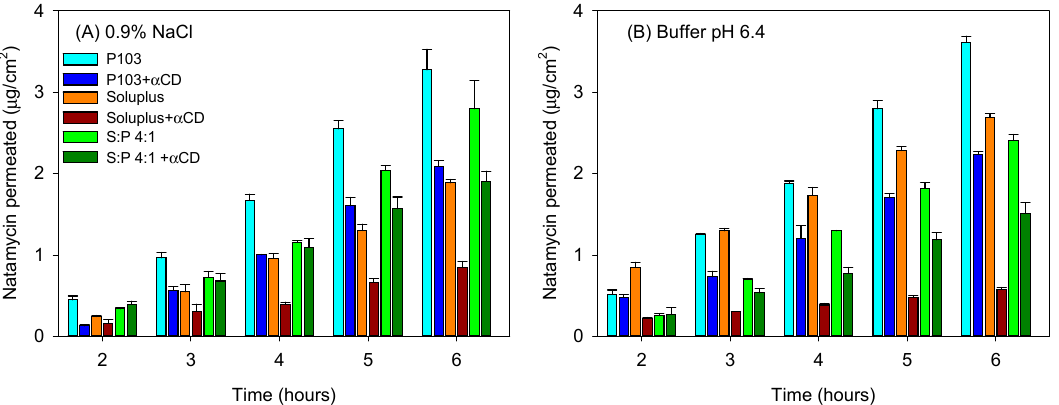
Figure 8. Amount of natamycin permeated through bovine sclera and measured in the receptor chamber as a function of time. Natamycin was formulated in Soluplus and Pluronic micelles, Soluplus:Pluronic P103 4:1 v / v mixed micelles, and their poly(pseudo)rotaxanes in 0.9% NaCl ( A ) and pH 6.4 bu ff er ( B ). Total copolymer concentration was 10% w / v in all cases. Table 5. Transcleral steady state flux ( J ) and permeability coe ffi cients ( P app ) recorded for natamycin formulated in Soluplus and Pluronic micelles, Soluplus:Pluronic P103 4:1 v / v mixed micelles, and poly(pseudo)rotaxanes in 0.9% NaCl and pH 6.4 bu ff er. Total copolymer concentration was 10% w / v . Mean values and, in parenthesis, standard deviation (n = 3).